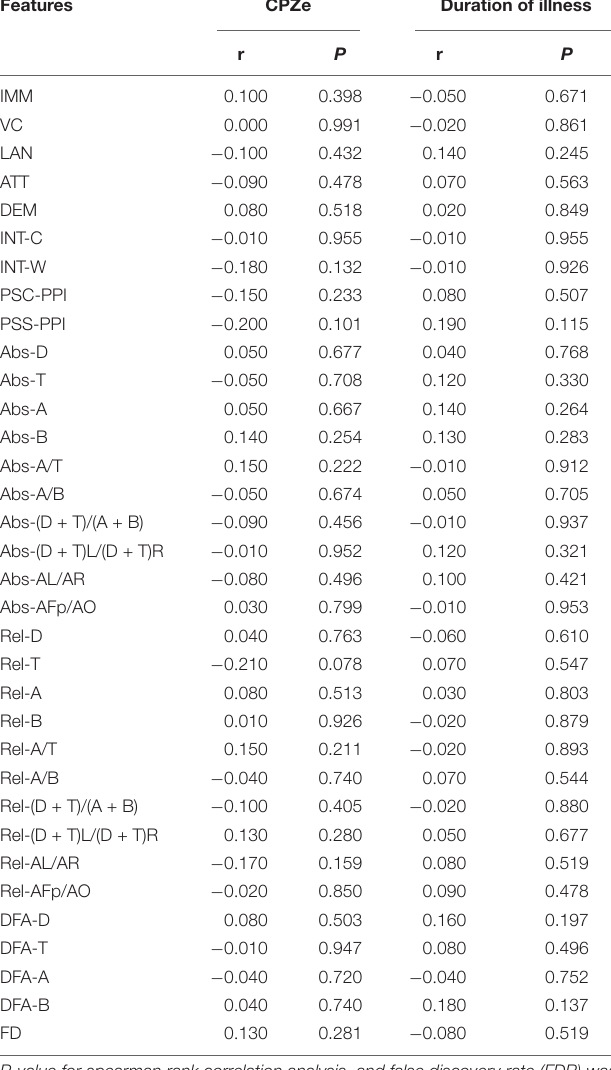
TABLE 5 | Correlation between all features and CPZs, duration of illness in patients.